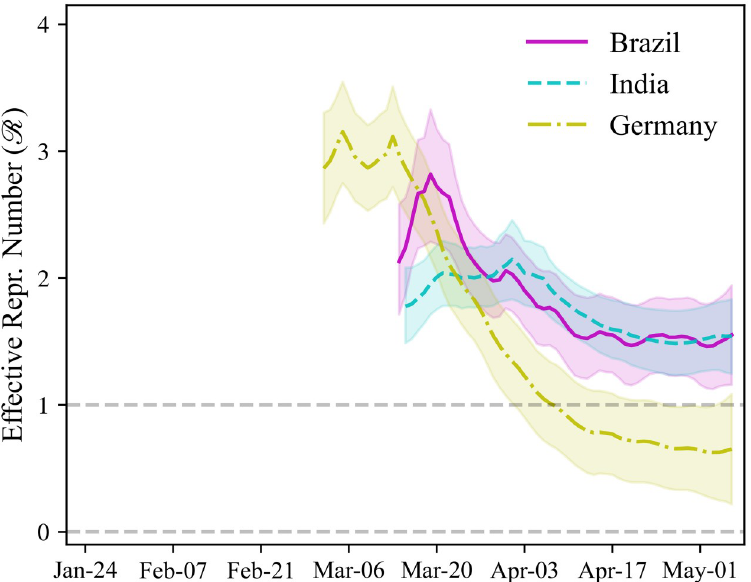
Fig 2. R of COVID-19: Brazil, India, and Germany. Estimates of the effective reproduction rate ( R t for selected countries. The sample consists of all dates after the total number of reported cases in the country has reached 100. 65% credible bounds shown by the shaded